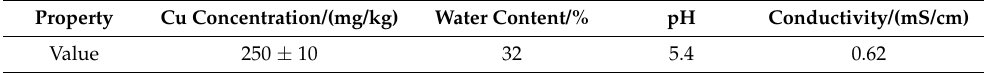
Table 1. Physical and chemical properties of the contaminated samples.